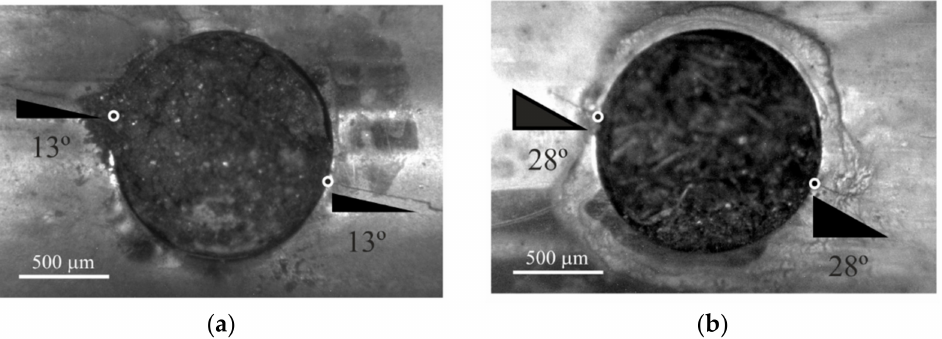
Figure 4. Experimental surface crack paths at the early stage of growth and crack initiation locations; ( a ) B/T = 2; and ( b ) B/T = 1